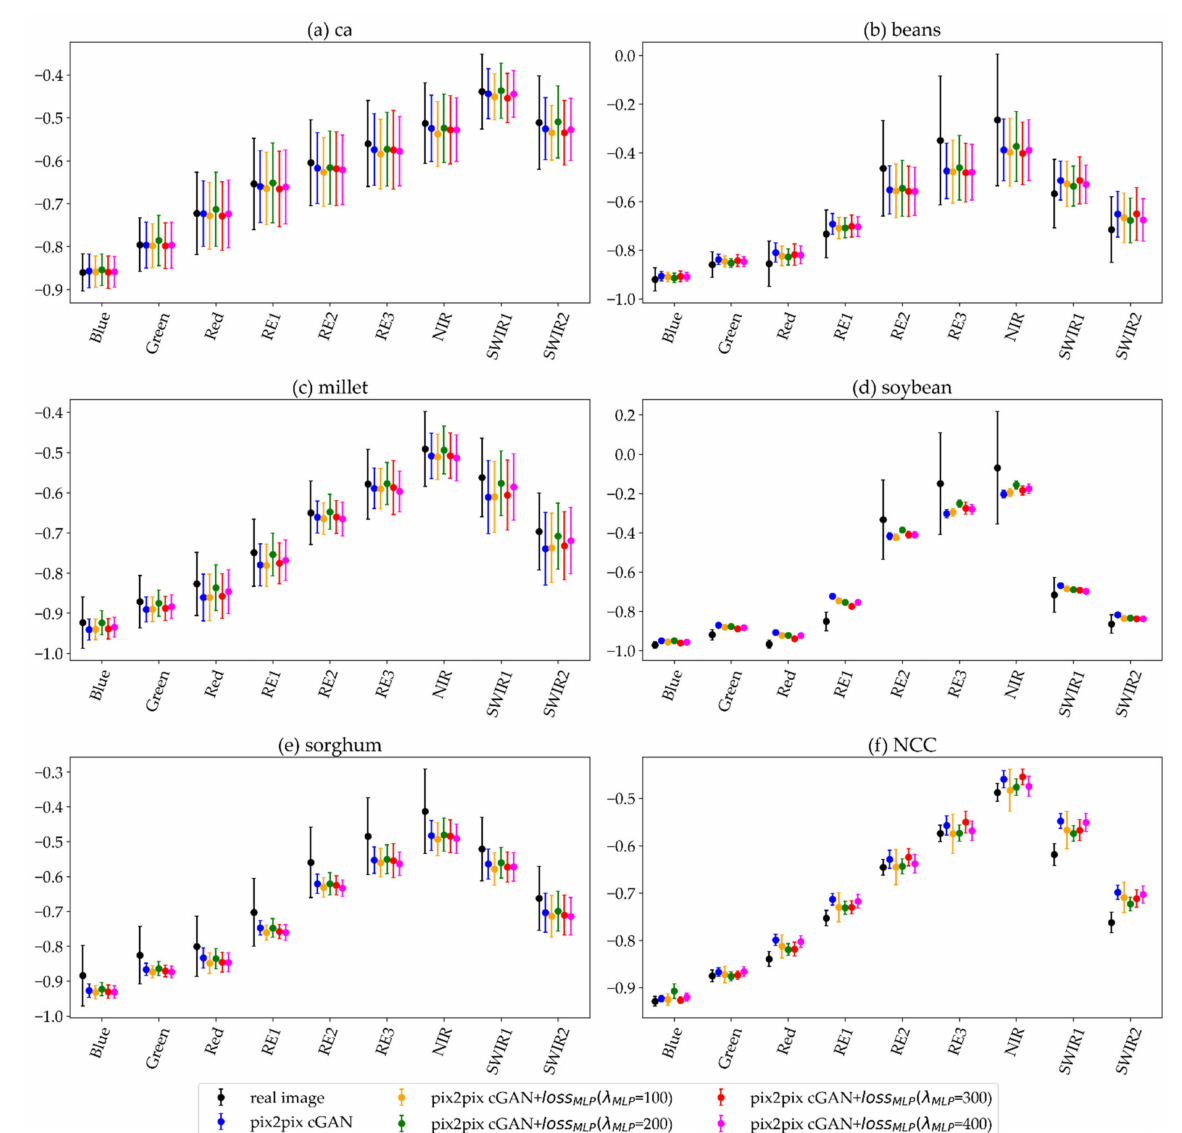
Figure 11. Pixel values comparison between the real and synthetic images produced with the original pix2pix cGAN (I-A) and the proposed approach with λ MLP equal to 100 (I-B), 200 (I-C), 300 (I-D) and 400 (I-E) for the classes: ( a ) conversion area; ( b ) beans; ( c ) millet; ( d ) soybean; ( e ) sorghum; and ( f )